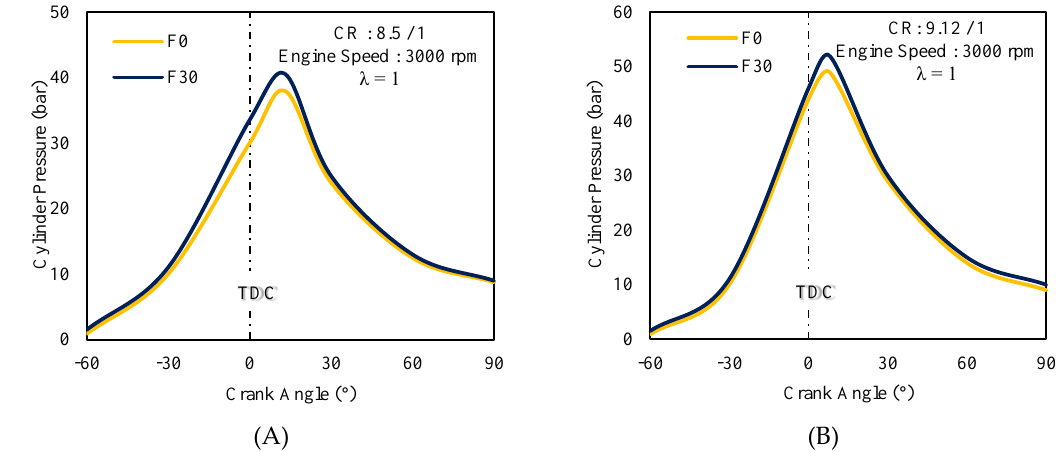
Figure 8. In-cylinder pressure by CRs at a CR of ( A ) 8.5:1 and ( B ) 9.12:1.